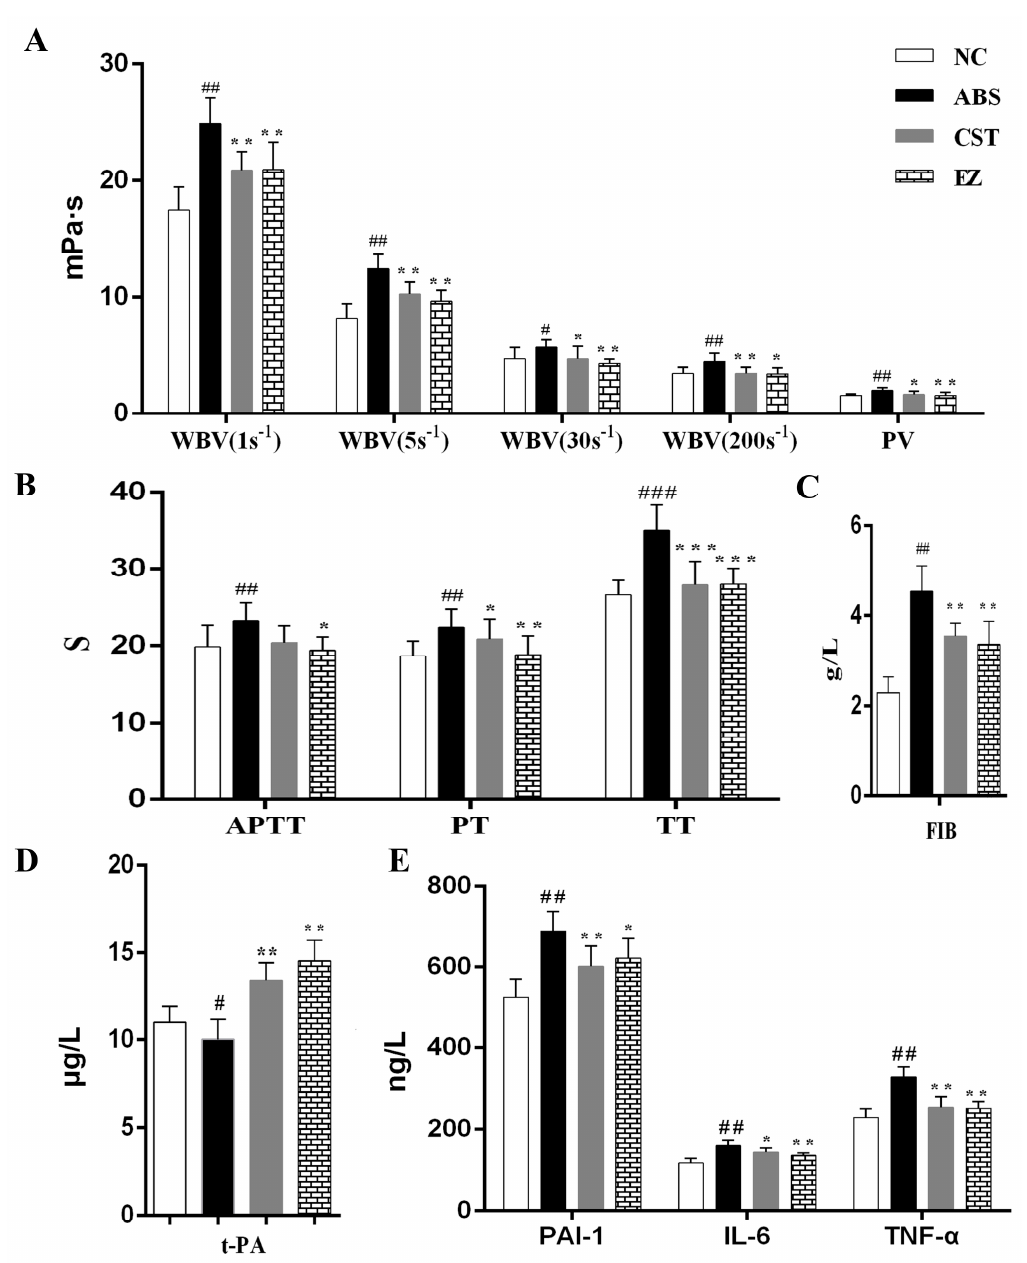
Figure 1. The influence of EZ on the related functions in normal control (NC), acute blood stasis (ABS), compound salvia tablets (CST), and EZ groups. Note: Whole blood viscosity, including 1 s − 1 , 5 s − 1 , 30 s − 1 , 200 s − 1 shear rates, and plasma viscosity ( A ); four blood coagulation indexes, including PT, APTT, TT, and FIB ( B , C ); fibrinolytic factors and inflammatory factors ( D , E ); compared with NC group, ### , ## and # represent p < 0.001, p < 0.01 and p < 0.05, respectively; compared with ABS group, ***, ** and * represent p < 0.001, p < 0.01 and p < 0.05, respectively.